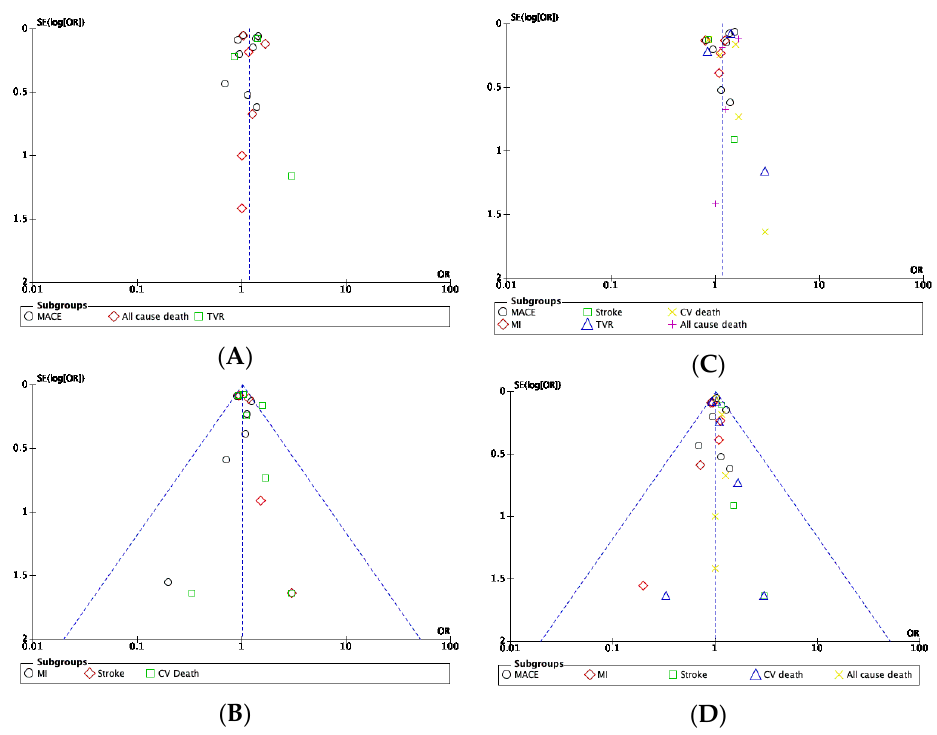
Figure 7. ( A ) Funnel plot of the publication bias within the studies assessed in the primary analysis using a random-effects model. ( B ) Funnel plot of the publication bias within the studies assessed in the primary analysis using a fixed-effects model. ( C ) Funnel plot of the publication bias within studies analyzing the combination of clopidogrel and PPIs. ( D ) Funnel plot of the publication bias within the RCTs.